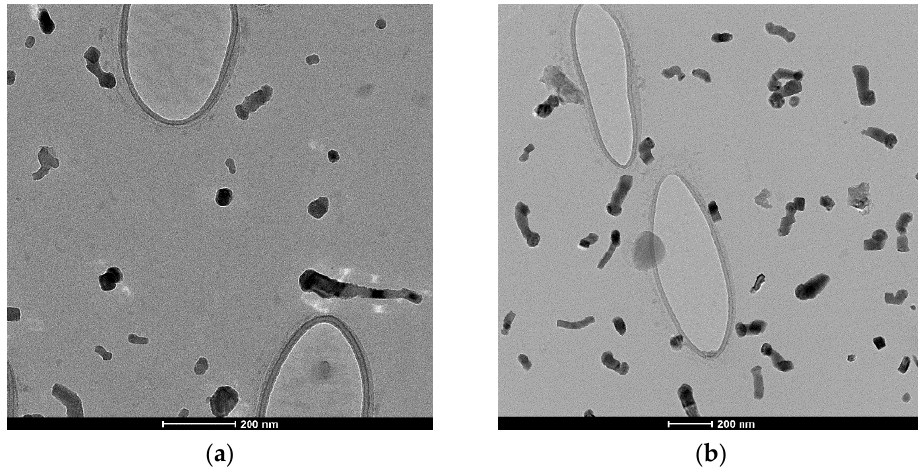
Figure 4. Bright field TEM of ( a ) cement and ( b ) concrete dust on SLG grid.